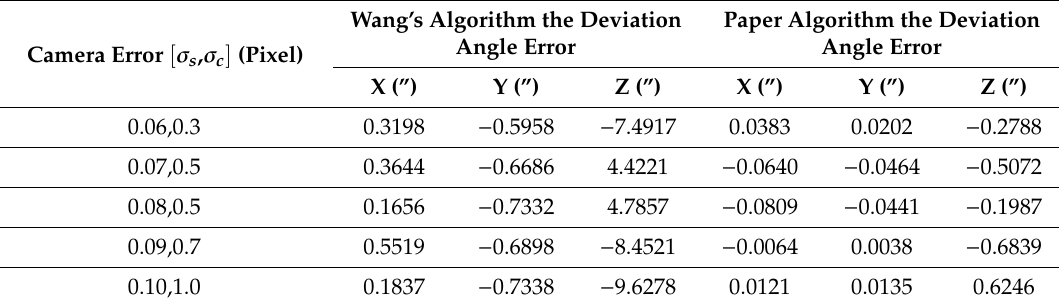
Table 4. The Deviation Angle Error of Different Parameter.